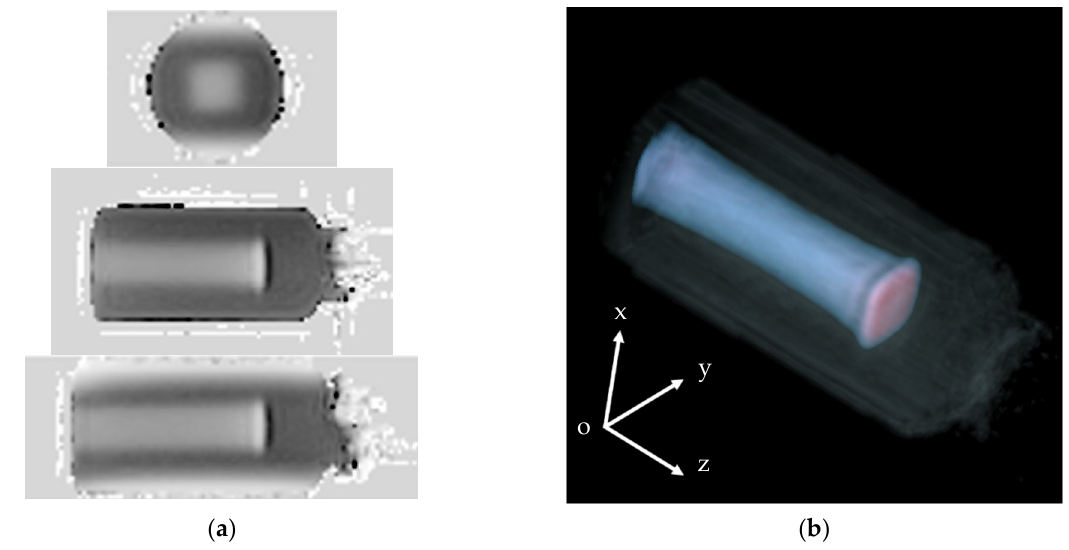
Figure 1. 3D image of NC-FG-irradiated 450 Gy ESD obtained from MRI imaging. ( a ) Using MPR, ( b ) using volume rendering (VR). The upper, center, and lower panels in ( a ) are xy, yz, and xz views, respectively.